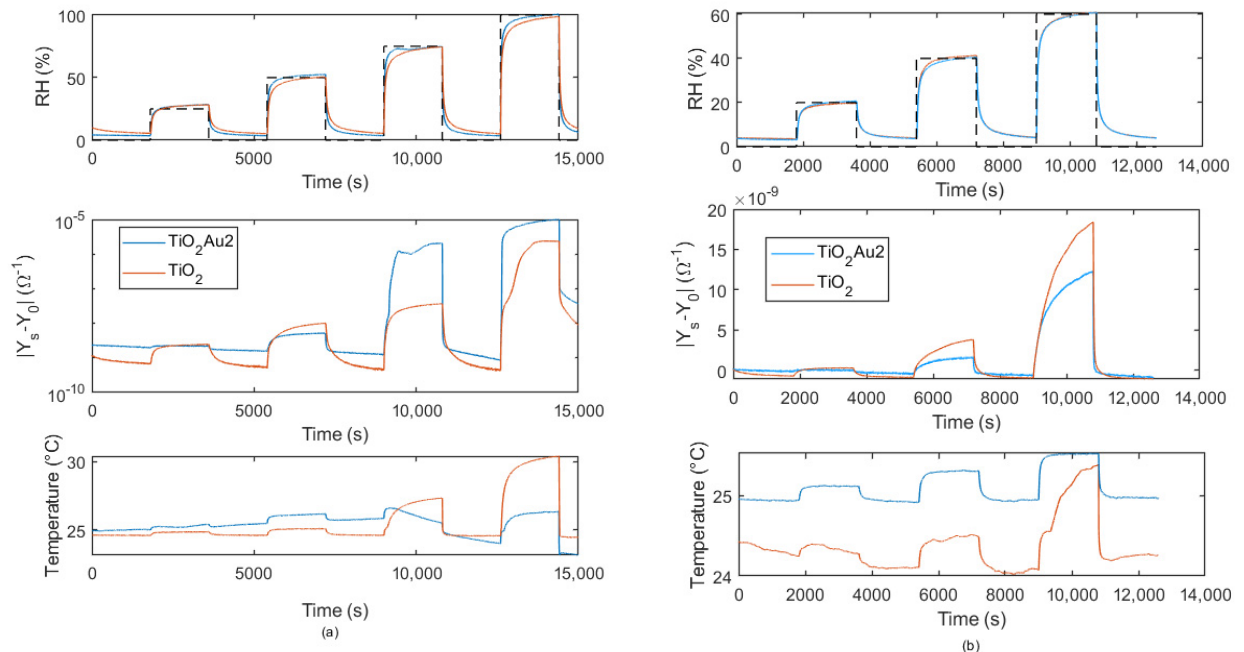
Figure 15. Dynamical response of the TiO 2 (blue line) and TiO 2 Au2 (red line) sensing films to increasing RH pulses. The middle plots show the measured sensing-film admittance magnitude variations |Ys–Y 0 | versus time, where |Y 0 | is the film admittance at a reference RH level. During the measurements, increasing RH pulses steps of 30 min were applied followed by 30 min of recovery at 0% RH (upper plot, where the dashed black lines refer to the theoretical RH level set in the measurement chamber): ( a ) 25%, 50%, 75%, and 100% RH pulses; ( b ) 20%, 40%, and 60% RH pulses. The RH (upper plots) and the temperature (lower plots) were measured with the commercial sensors in the measurement chamber.